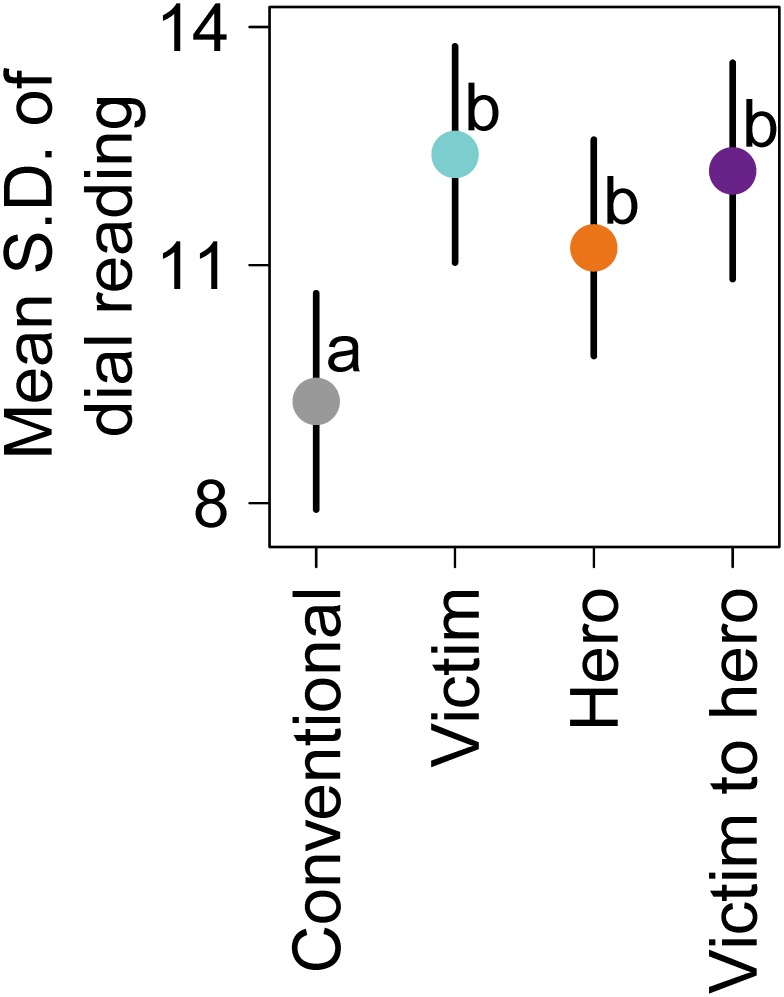
Mean standard deviation of dial readings by science message type.Point estimates and 95% confidence intervals were generated from marginal means of the linear mixed-effects models as described in Methods: Statistical analyses. Letters adjacent to point estimates denote statistically significant differences.